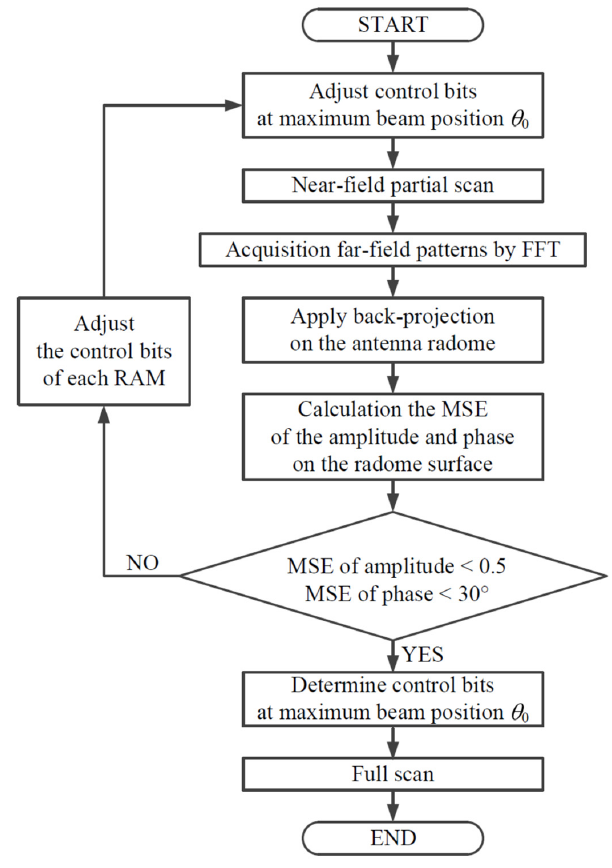
Figure 12. Flow chart for the pattern calibrations.